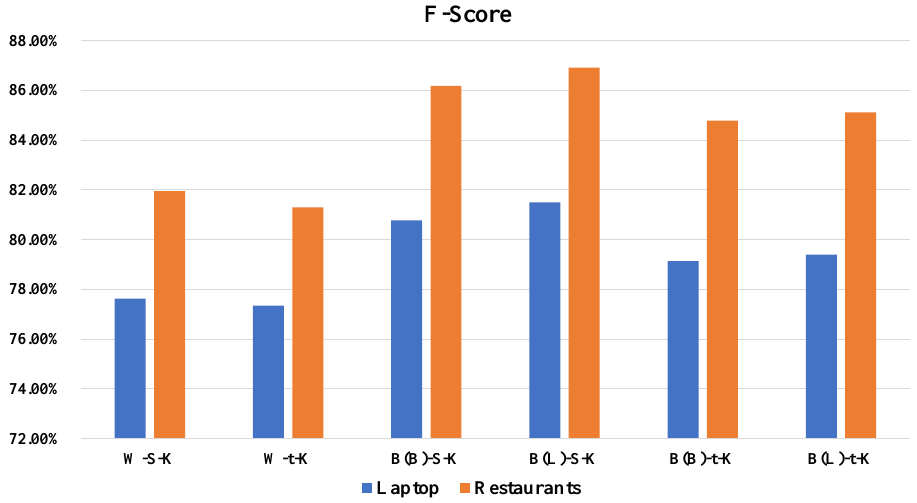
Figure 6. Comparison of various model combinations in terms of F-score